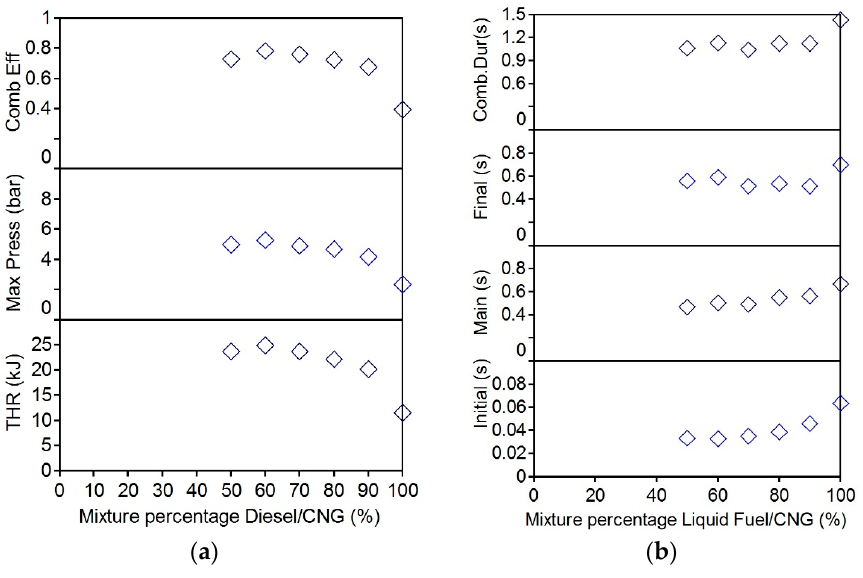
Figure 4. Combustion performance for various diesel/compressed natural gas (CNG) compositions at 0 ms injection gap ( a ) combustion performance; ( b ) combustion phasing.